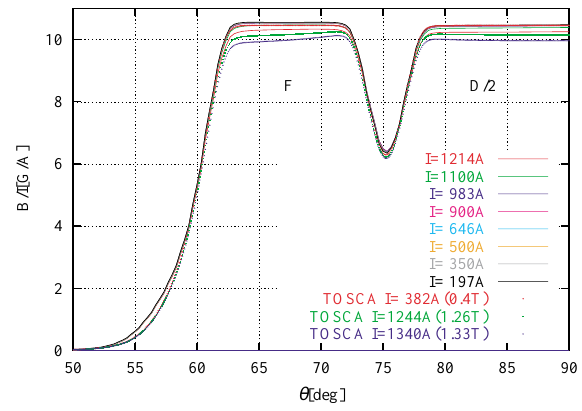
FIG. 13. (Color) Current normalized field strength distribution. circles show the results of magnetic field calculations and the results of field measurements, respectively. The ex- citation curve of the measurements almost corresponds to the curve of the field calculations. The apparent threshold of the saturation phenomenon exists around the main coil current of I (cid:1) 1200 A. But the nonlinearity caused by magnetic pole saturation can be seen above a coil current of I (cid:1) 900 A from the curve of the field strength normal- ized by the coil current.